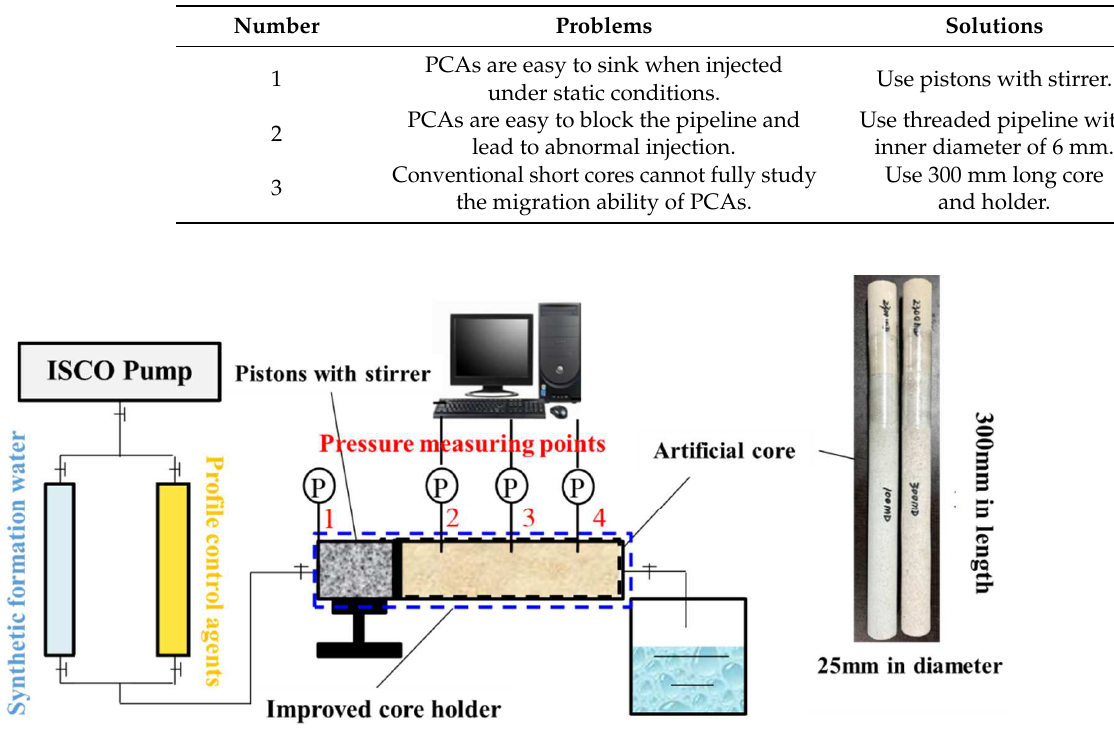
Figure 19. Improved experimental device.